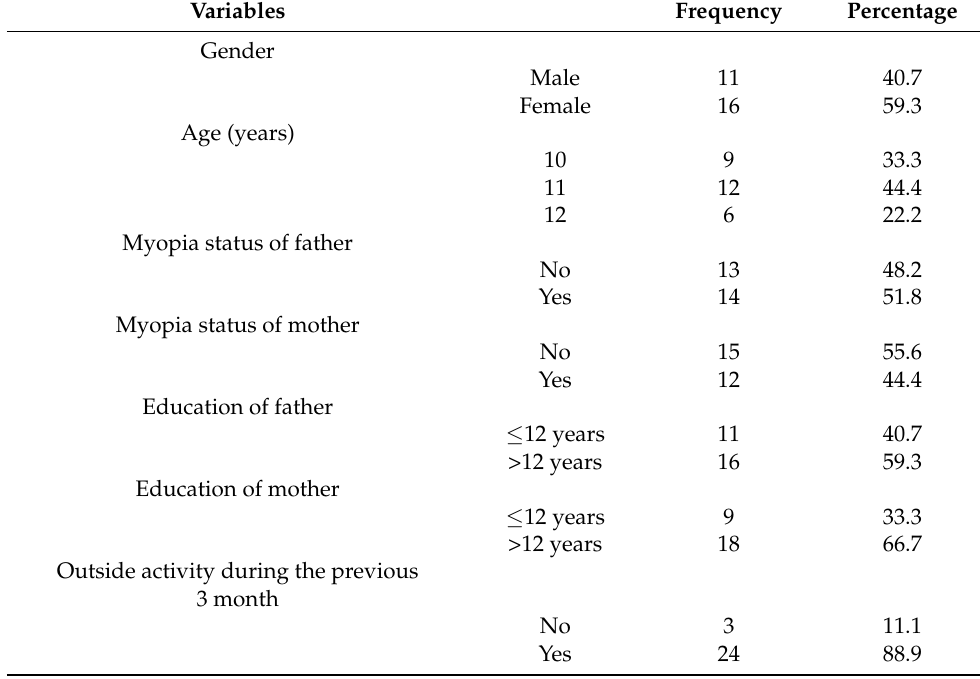
Table 1. Demographic data of the